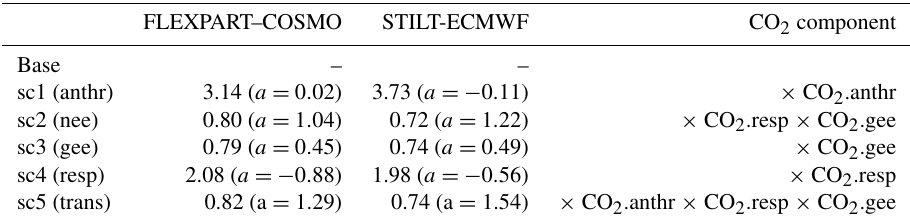
Table 5. Scaling factors based on the weighted least squares regression fitting slope b and intercept a (in parenthesis) used to minimize the CO 2 model bias for JJA (2012–2015).